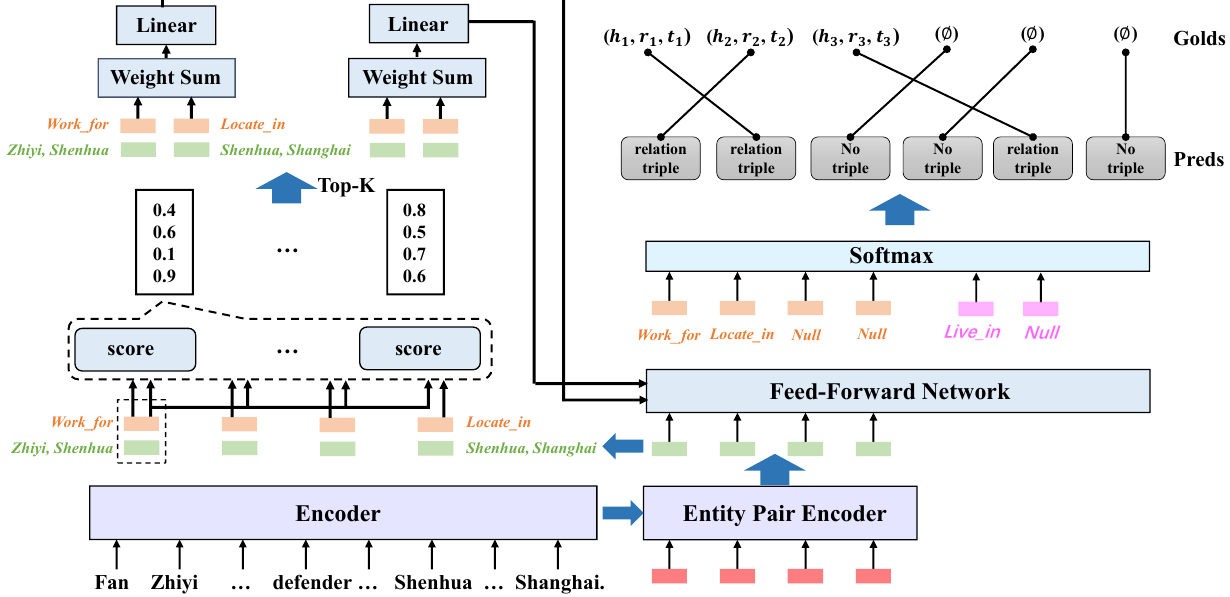
Figure 3. The framework of the proposed model. The red box is a raw entity pair representation. The green box is an encoded entity pair representation. The orange box is a relation representation. The pink box is a relation corresponding to an implicit entity pair. As illustrated in the left upper part, we set k = 2, which means only 2 triple pairs are selected in the final